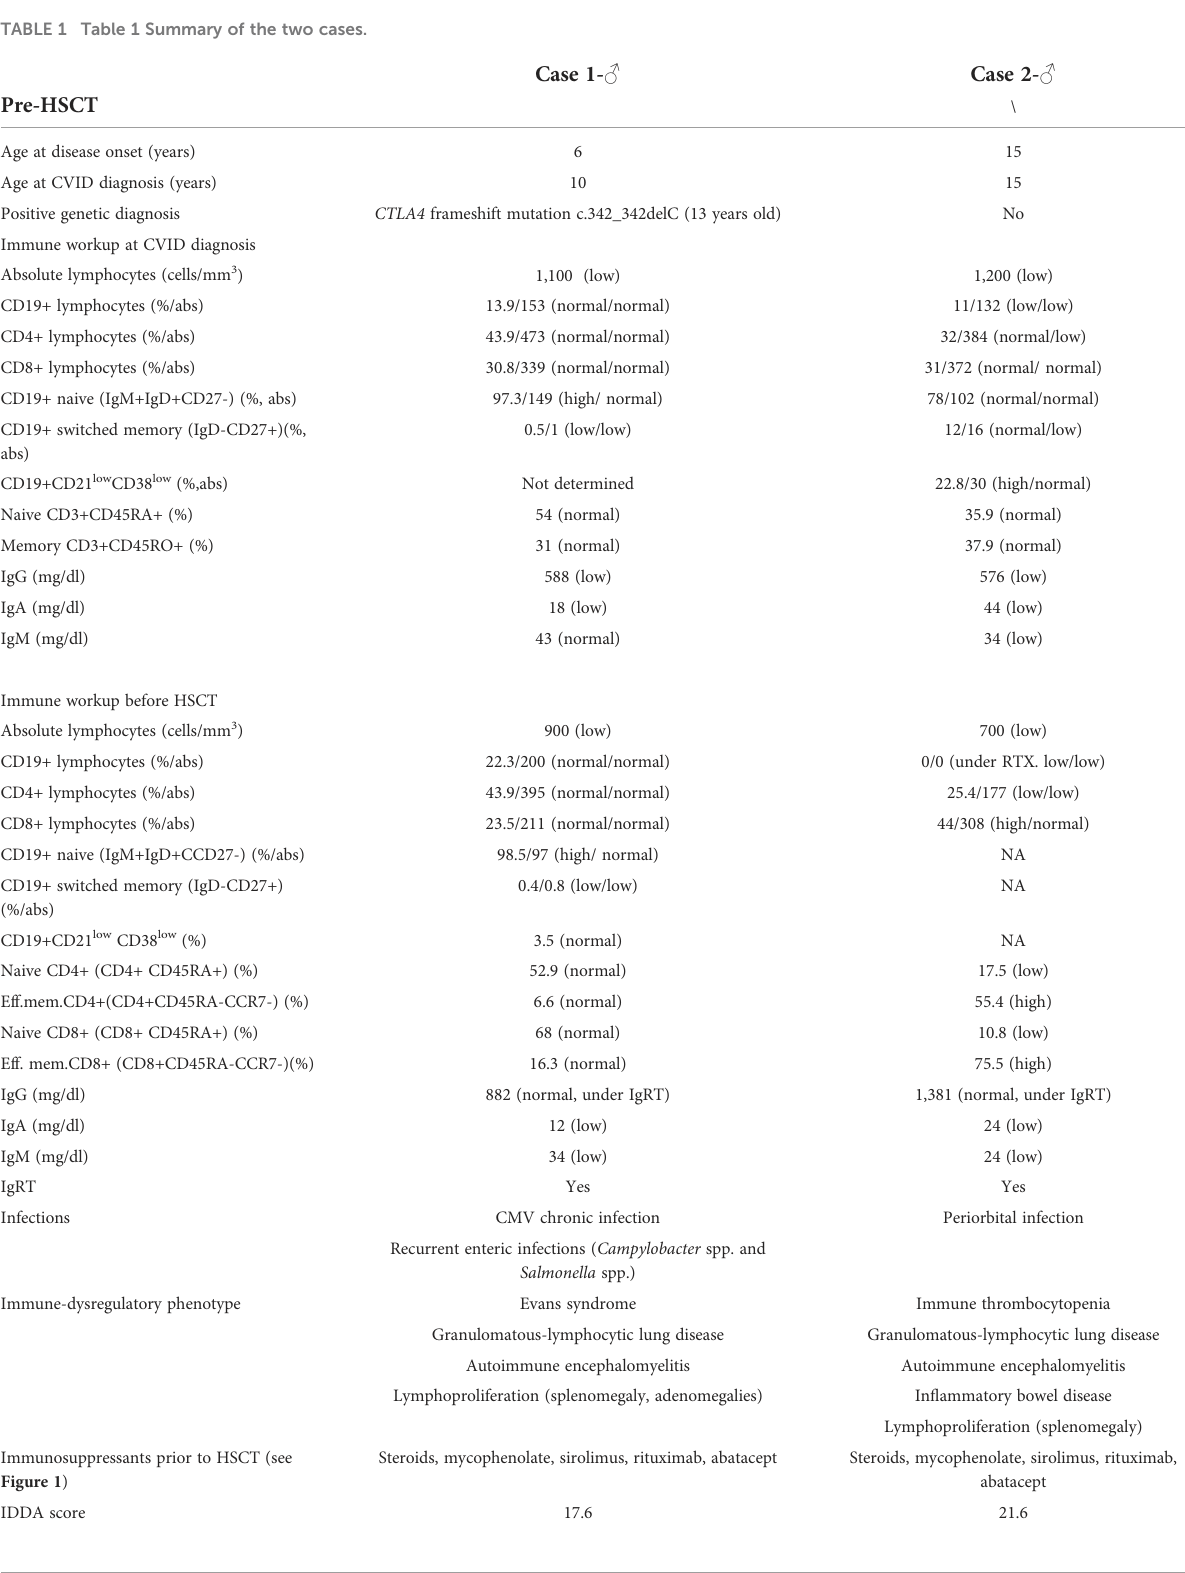
TABLE 1 Table 1 Summary of the two